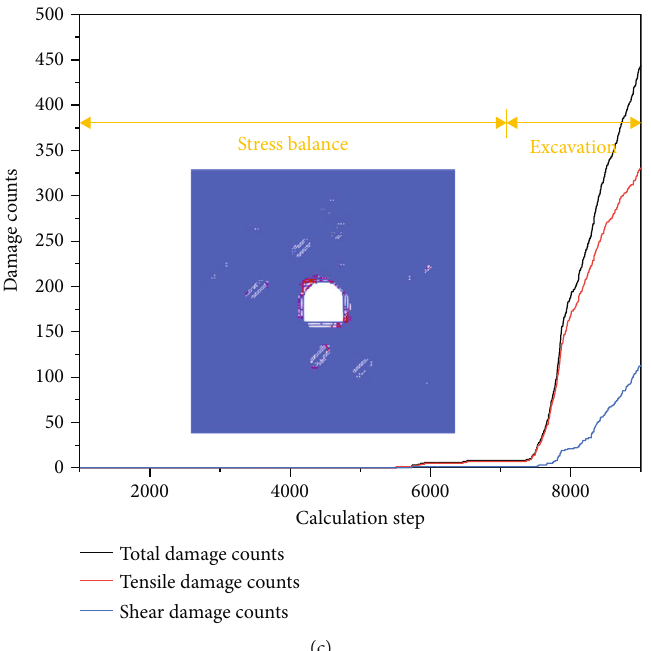
Figure 6: Excavation damage counts under di ff erent tunnel shapes. (a) Circular-shaped hole. (b) Horseshoe-shaped hole. (c) “ U ” -shaped hole.